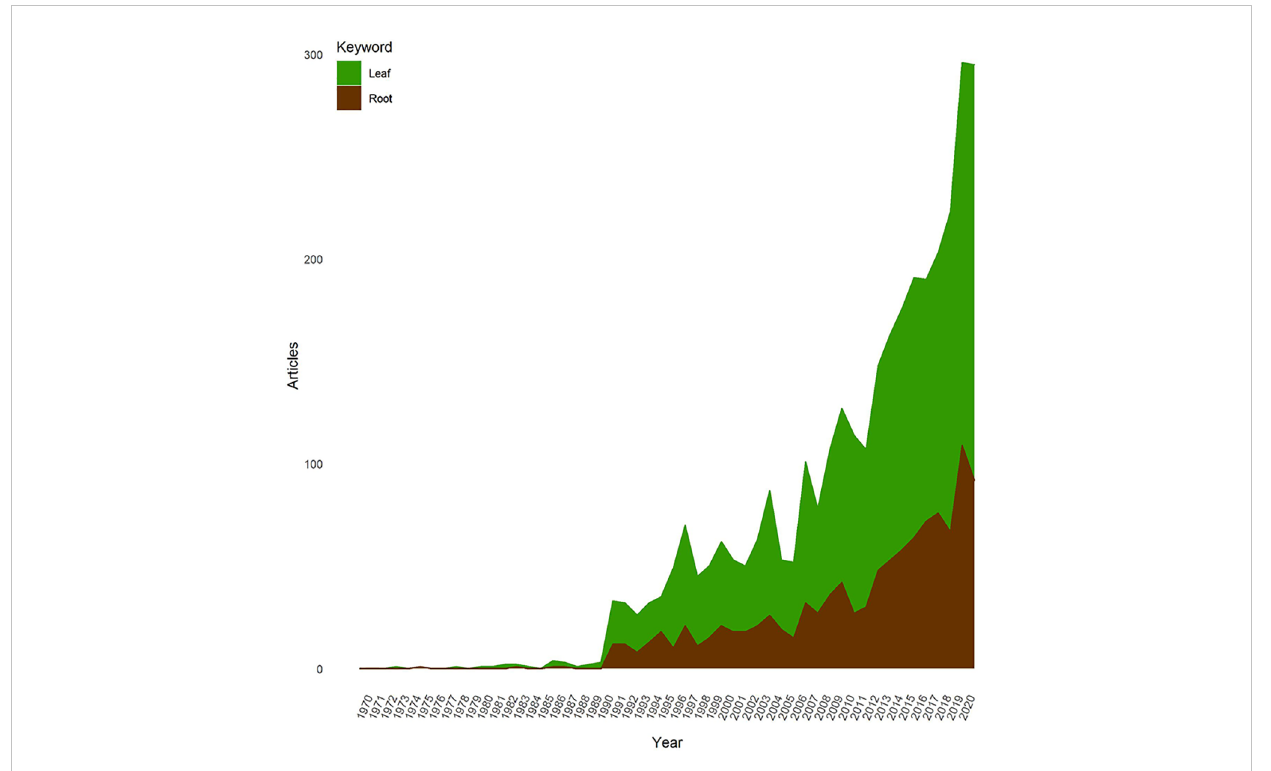
FIGURE 5 Temporal evolution of outputs on the shoot/root plasticity during drought and recovery research from 1900 to 2021.